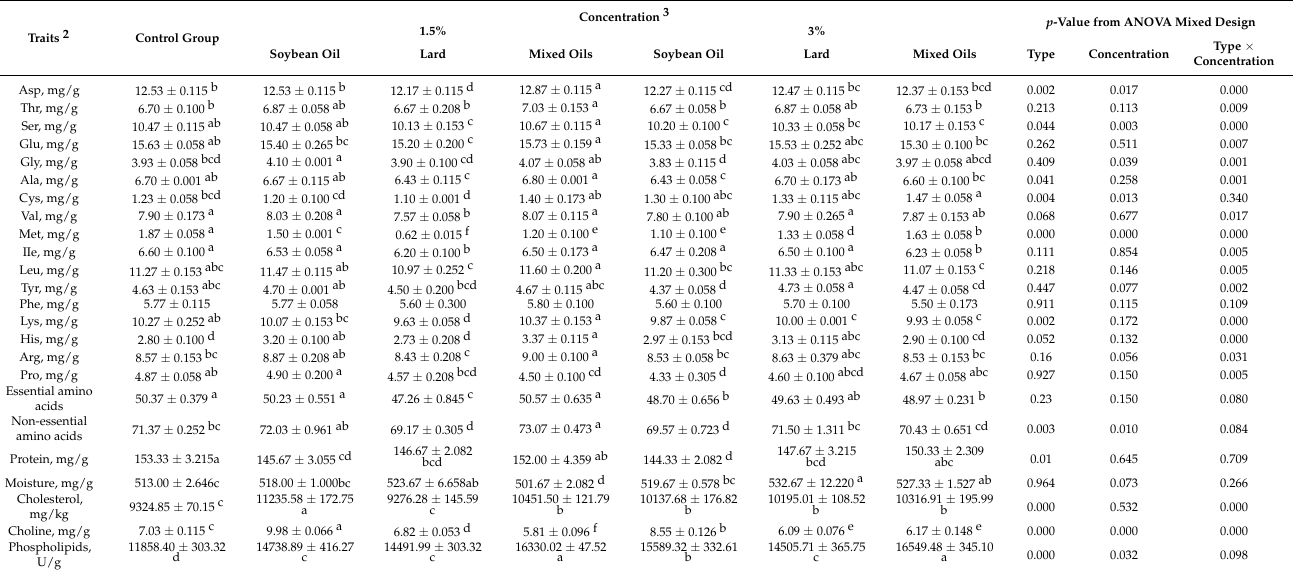
Table 6. Effects of different concentrations of soybean oil, lard, and mixed oils on protein, amino acids, moisture, cholesterol, choline, and phospholipids in raw egg yolk 1 .